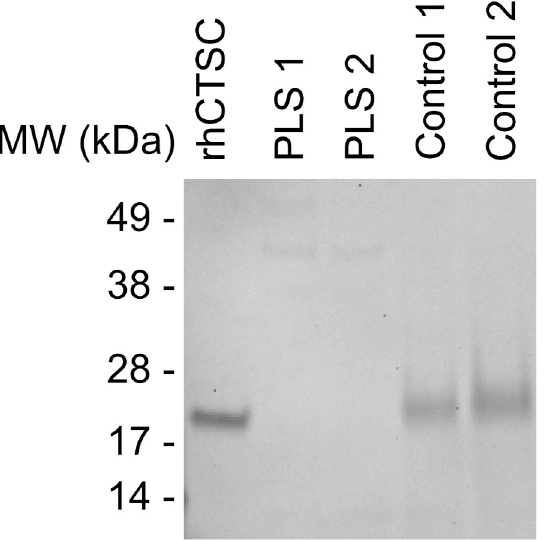
Fig 3. Immunoblot of CTSC on neutrophil lysates of family A and two healthy controls. Neutrophil lysates (31,250 cell equivalents/sample) from patients of family A and two healthy controls are shown. Recombinant CTSC (1.0 ng/ lane) is shown as a positive control. The blot is one out of? similar blots.